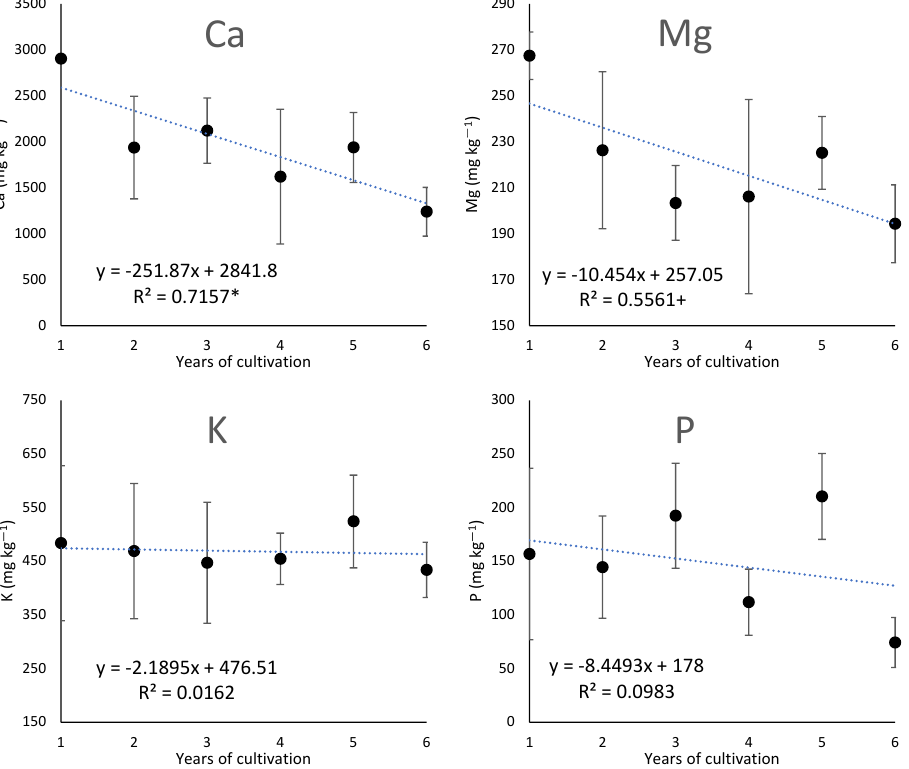
Figure 5. Relationships between years of ginseng cultivation and exchangeable cations and available phosphorus in the soil. Mean values ± standard errors ( n = 3). + Represents significance at the 0.10 probability level. * Represents significance at the 0.05 probability level.